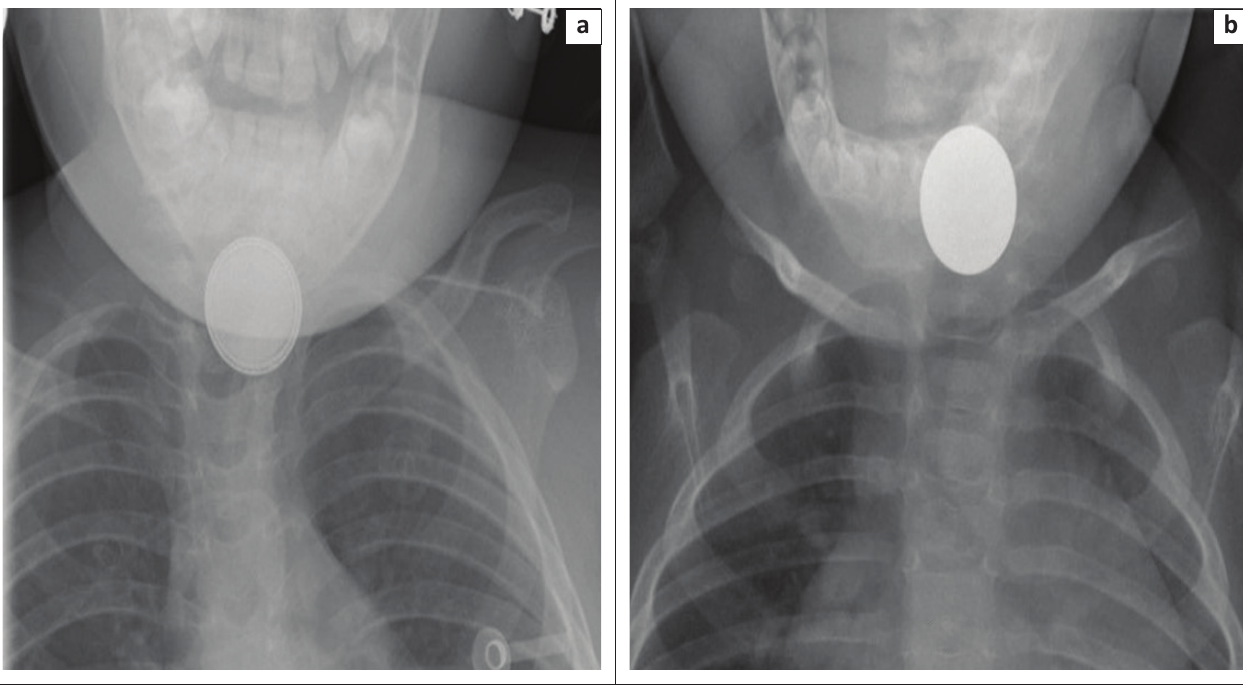
FIGURE 2: Magnified frontal radiographic images of the neck of two different patients with an ingested button battery (a) and a coin (b). A button battery has a ‘halo sign’ or a double density at its periphery en face, whilst a coin appears as a discoid radiodense object of uniform